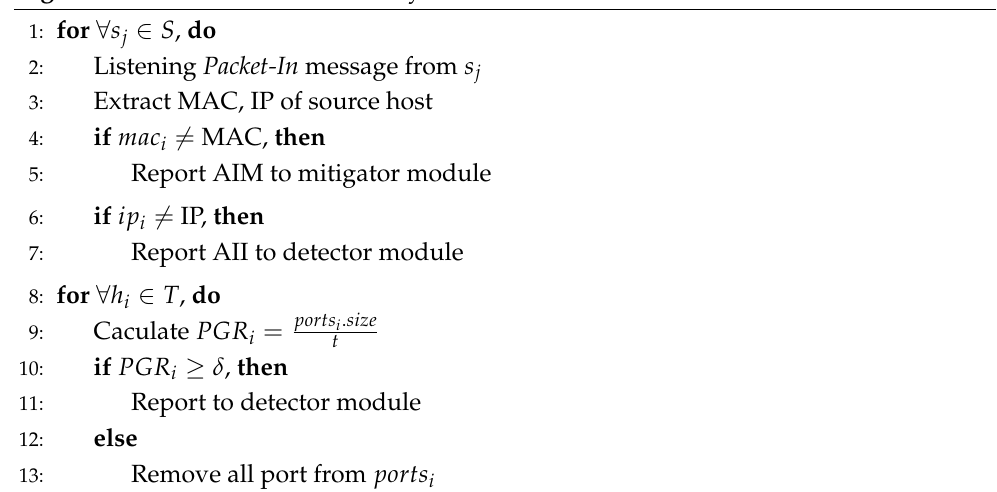
Algorithm 2 Mechanism of Anomaly